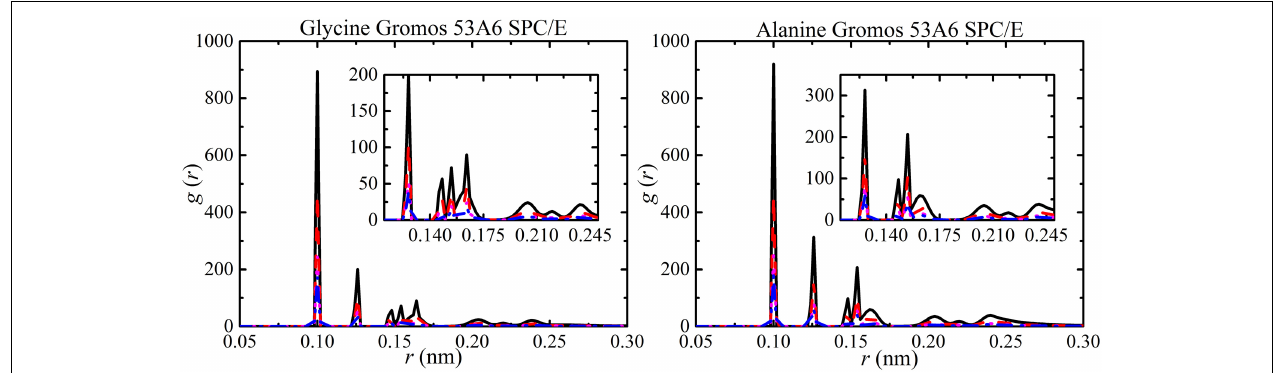
FIGURE 9 | RDFs of amino acid aggregates at different amino acid concentrations [i.e., 50 ( ), 100 ( ), 200 ( ), and 300mg/ml ( )] and different force fields at 298 K.